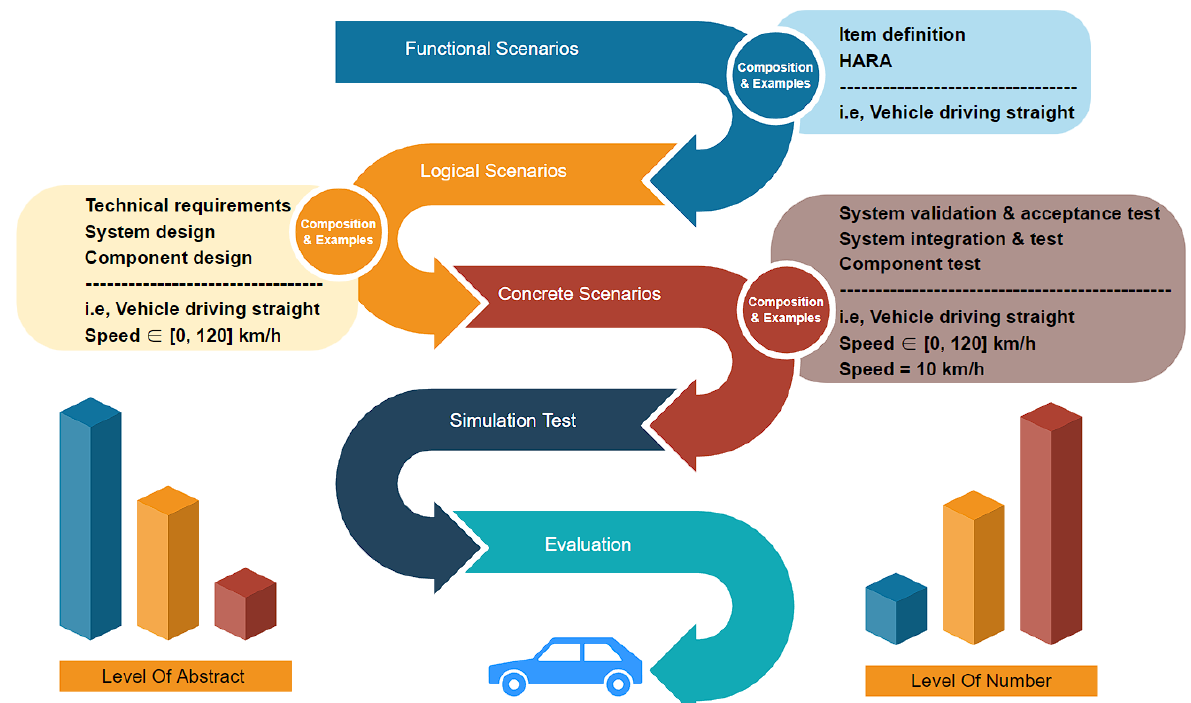
Figure 2. The “function-logic-concrete” three-tier hierarchy of scenarios and the testing process; HARA: hazard analysis and risk